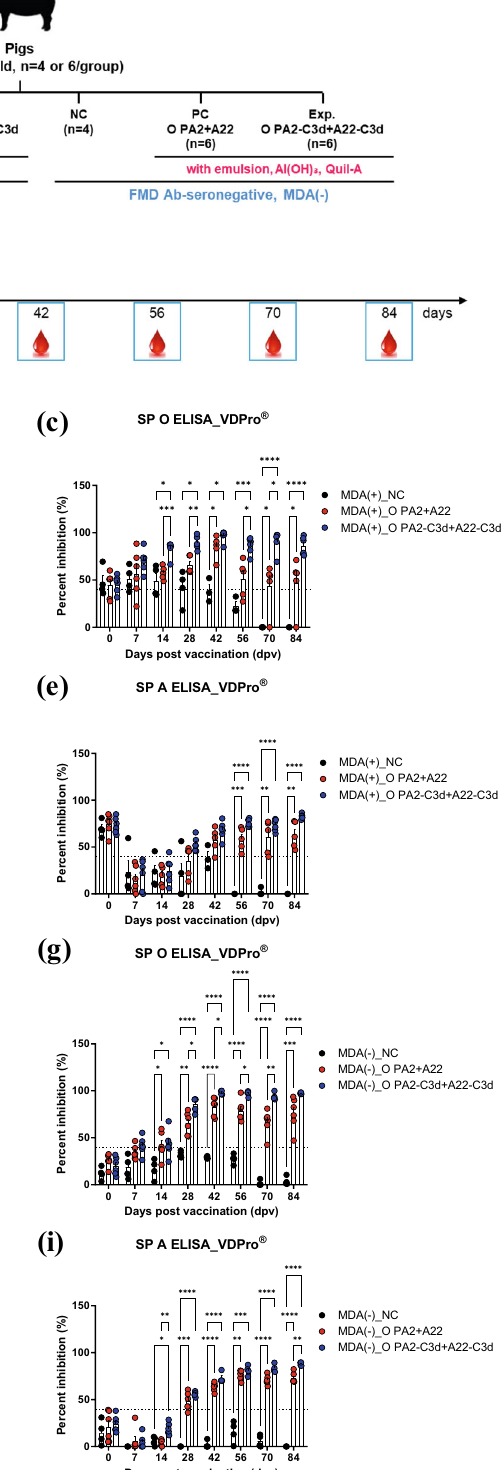
the PC or NC groups. The expression levels of CD80 (Fig. 7n), CTLA4 (Fig. 7r), CD21 (Fig. 7s), CD28 (Fig. 7t), and ICOS (Fig. 7u) were signi fi cantly different between the experimental and NC groups in the MDA( + )/MDA( − ) conditions (CD80: p < 0.01, p < 0.001, respectively; CTLA4: p < 0.01, p < 0.001,